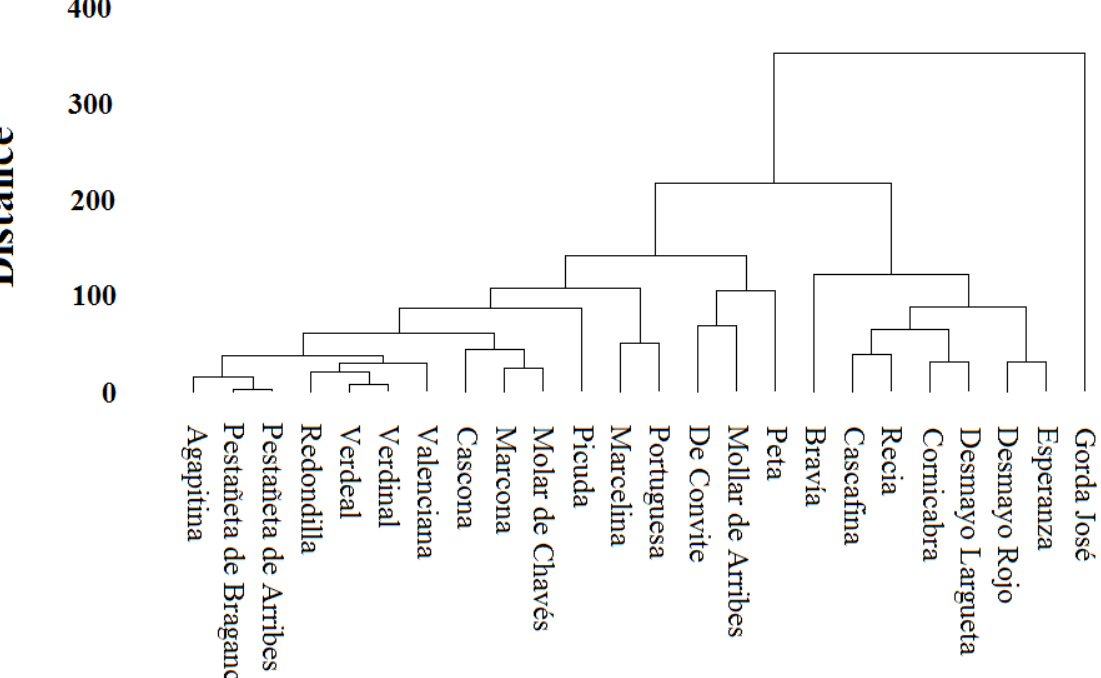
Figure 2. Dendrogram produced using the furthest neighbor method (Euclidean) from the agromorphological and chemical characteristics of traditional almond cultivars included in the study.